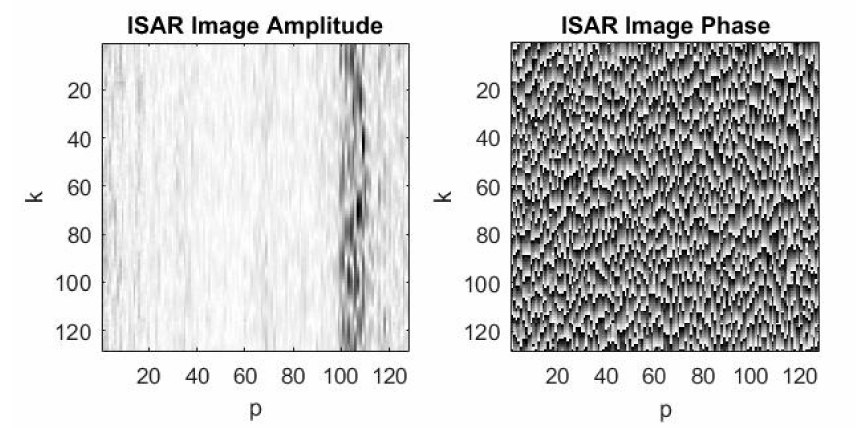
Figure 8. Complex image after azimuth compression of the range compressed ISAR signal with –15 dB signal to noise ratio: ( a ) ISAR image amplitude; ( b ) ISAR image phase.